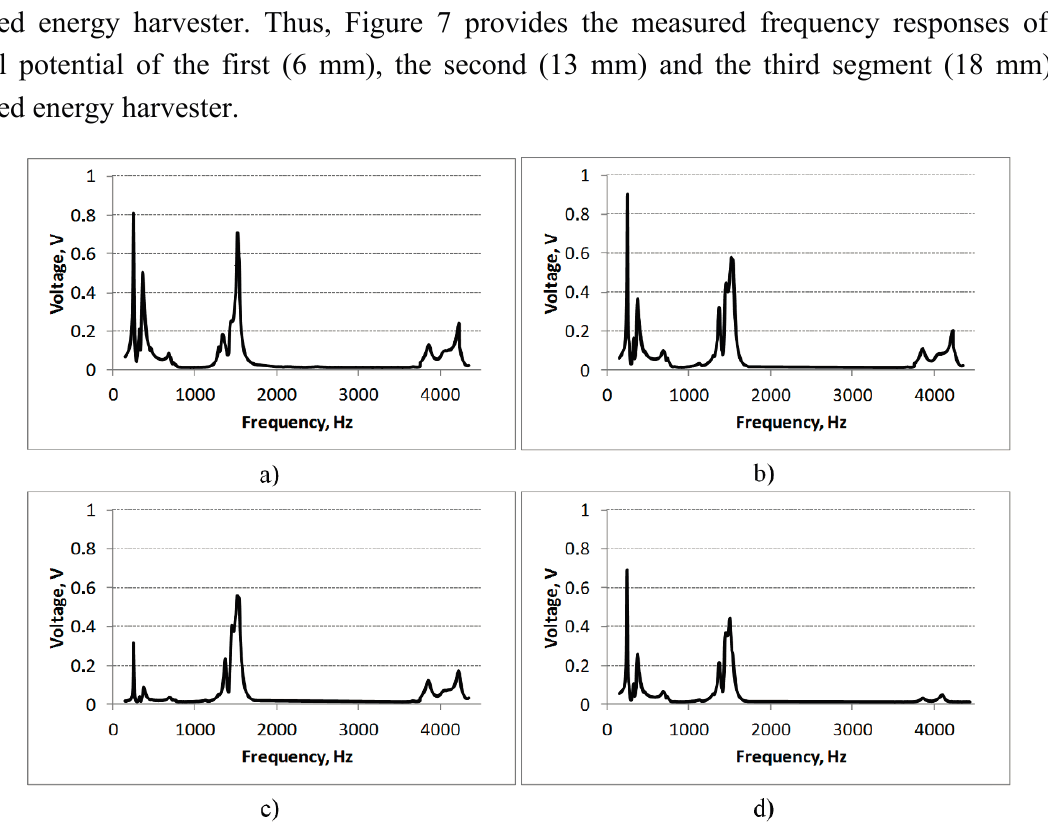
Figure 7. Measured frequency response of output voltage of the first (16 mm, a ), second (13 mm, b ) and third (18 mm, c ) segment generated by the segmented energy harvester in comparison with the frequency response of output voltage of the non-segmented energy harvester ( d